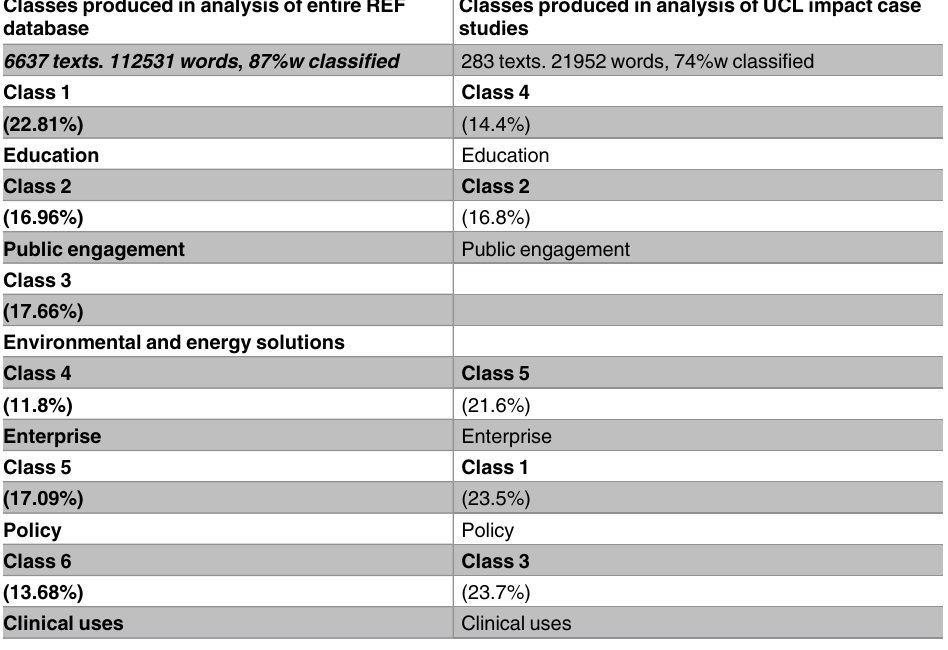
Table 2. Comparison of Classes produced by IRAMUTEQ analysis of entire REF impact database of case studies and UCL impact case studies.